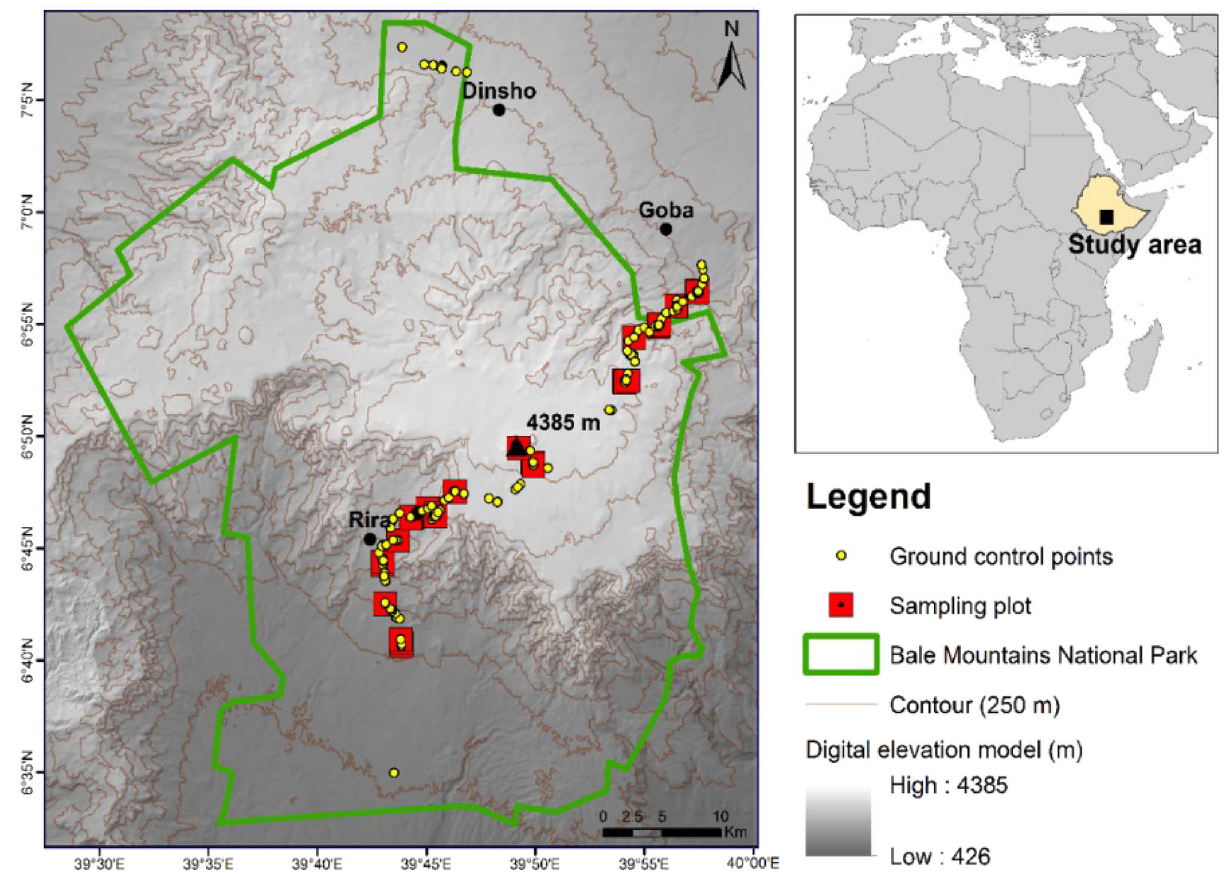
Figure 1. Map of the study area, including the transect sampling plots’ location, ground controlling points, and the Bale Mountain National Park (BMNP) boundaries (Prepared by: Mirela Beloiu and Yohannes O Kidane using QGIS 3.4. 52 and Digital Elevation Model acquired from United States Geological Survey (USGS) 51